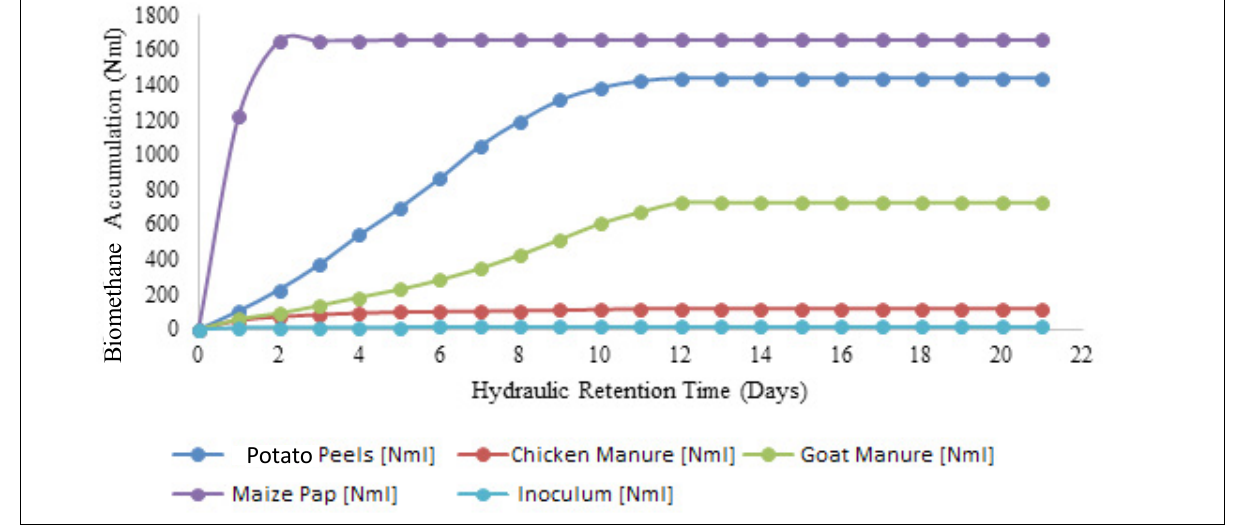
Figure 6: Biomethane production through mono-digestion of substrates.